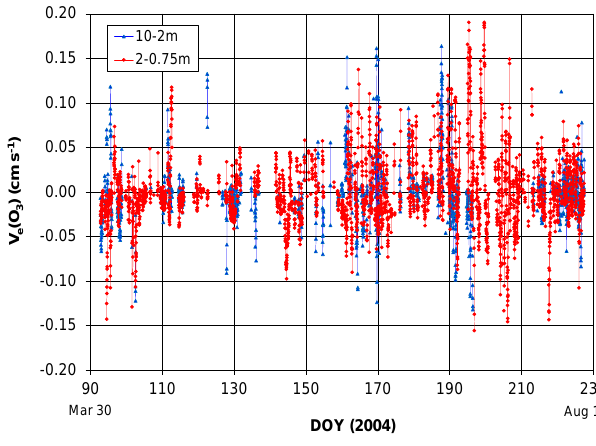
Fig. 8. Ozone exchange velocity results from the { 10–2m } and { 2–0.75m } gradients for the entire